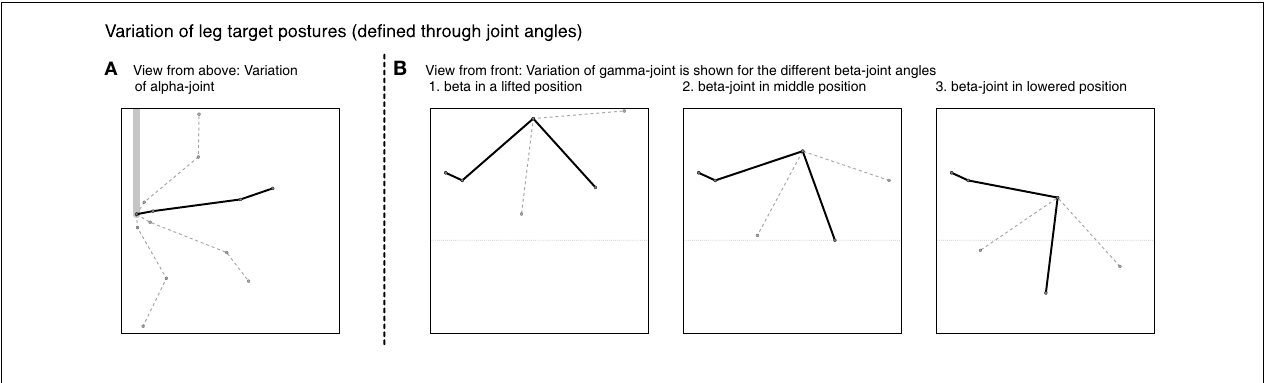
the three different figures show the different postures stemming from the variation of the beta joint, each showing the three gamma joint values applied.